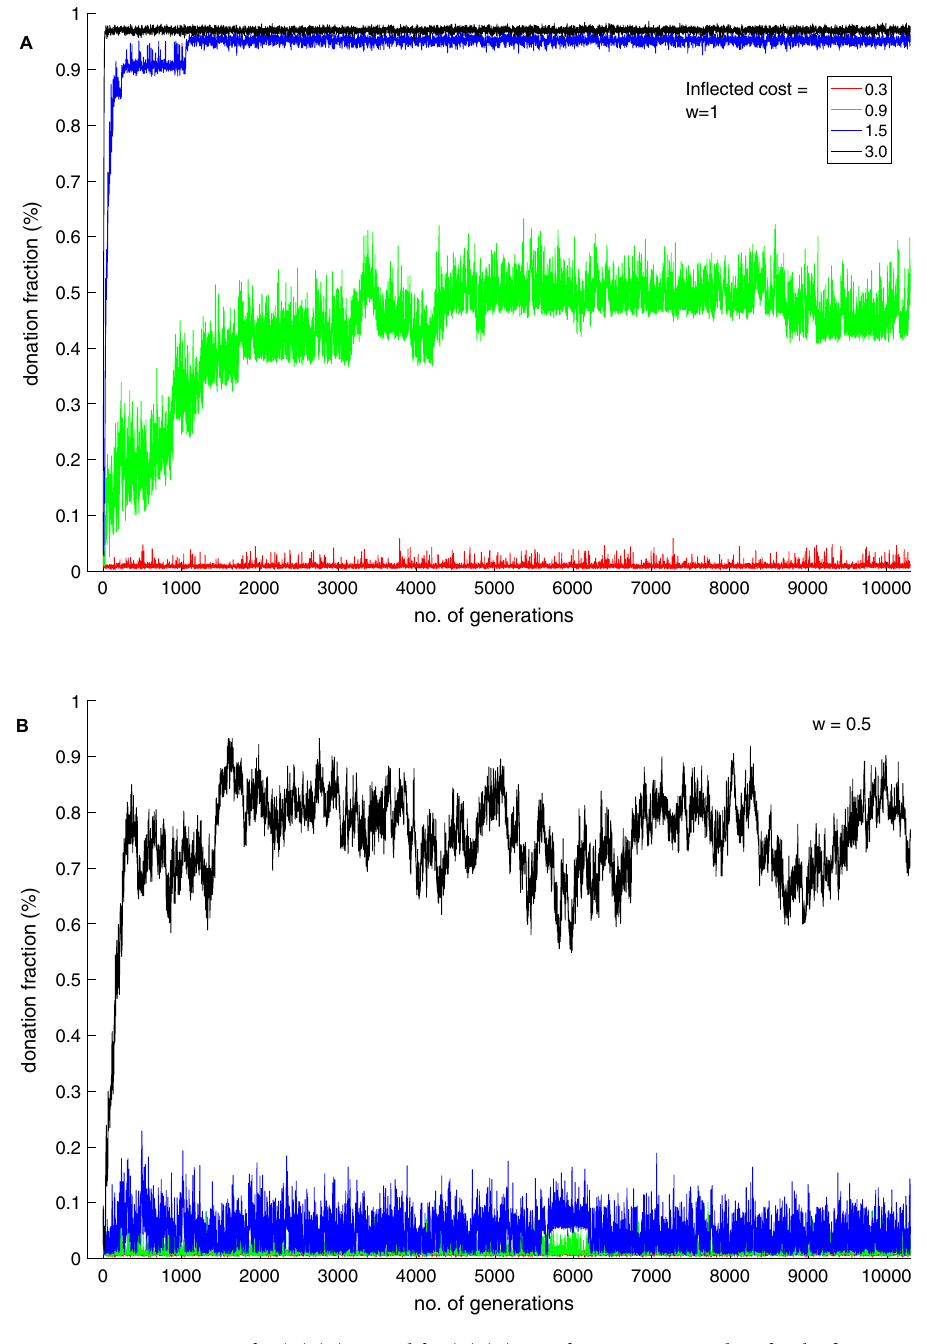
Figure 1. Donation rates for ( A ) ( w ) = 1 and for ( B ) ( w ) = 0.5 for various cost values for the first 10,000